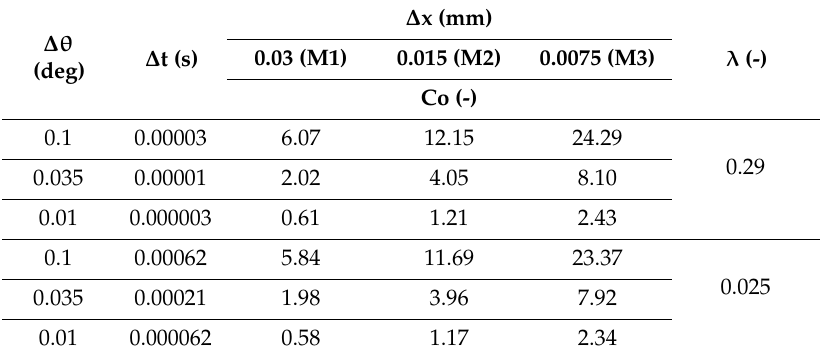
Figure 5. Average torque coefficient sensitivity analysis at λ max for DDES ( a ), SST Trans ( c ), SST kω ( e ) and at λ min for DDES ( b ), SST Trans ( d ), SST kω ( f ). Table 3. Courant numbers for different grids and time steps at maximum and minimum λ.